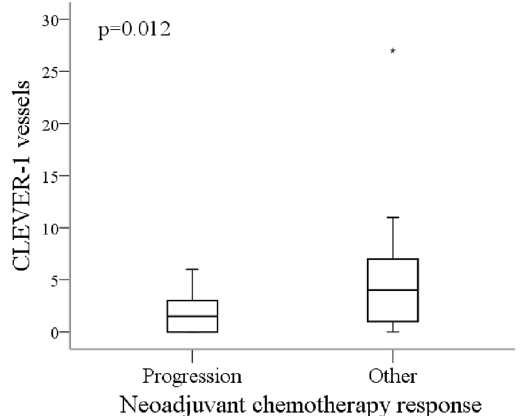
Figure 3. Association between neoadjuvant chemotherapy response (progression and other response) and CLEVER-1 + vessels (Mann-Whitney U test).